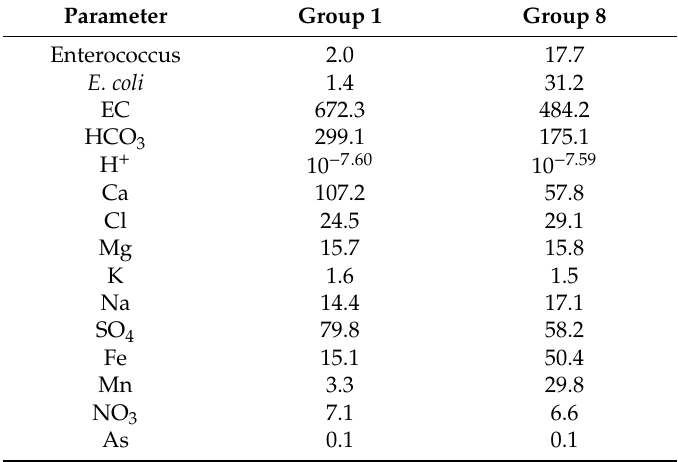
Table 5. Mean values of chemical and bacteriological parameters in groups 1 and 8. Highest coordinates are in